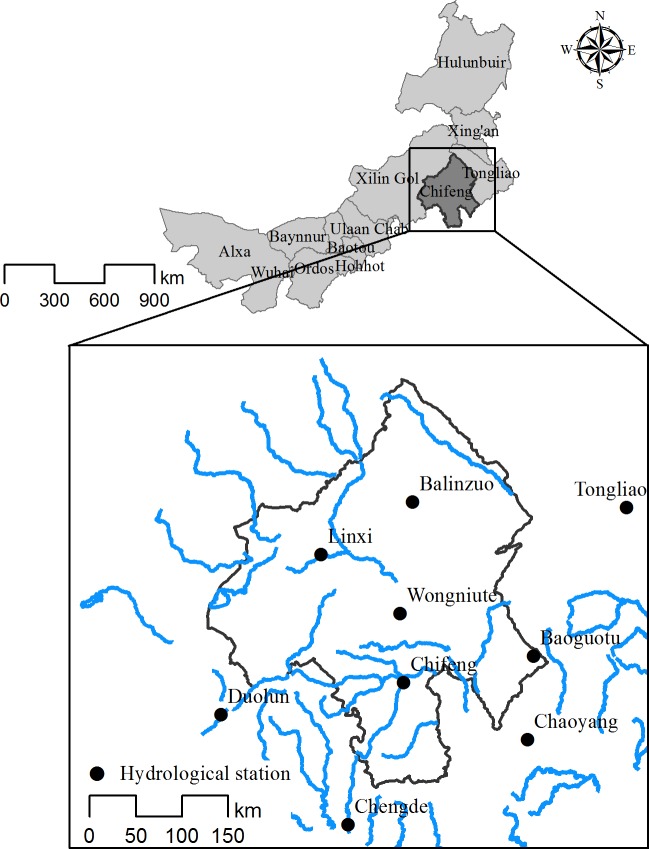
Map of the study area in Inner Mongolia.